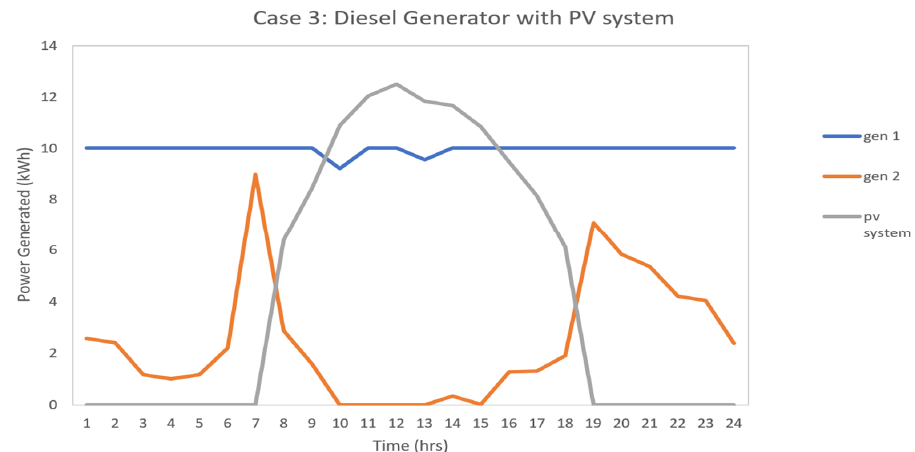
Figure 7. Case 3: power output variation from diesel generators and PV generator.